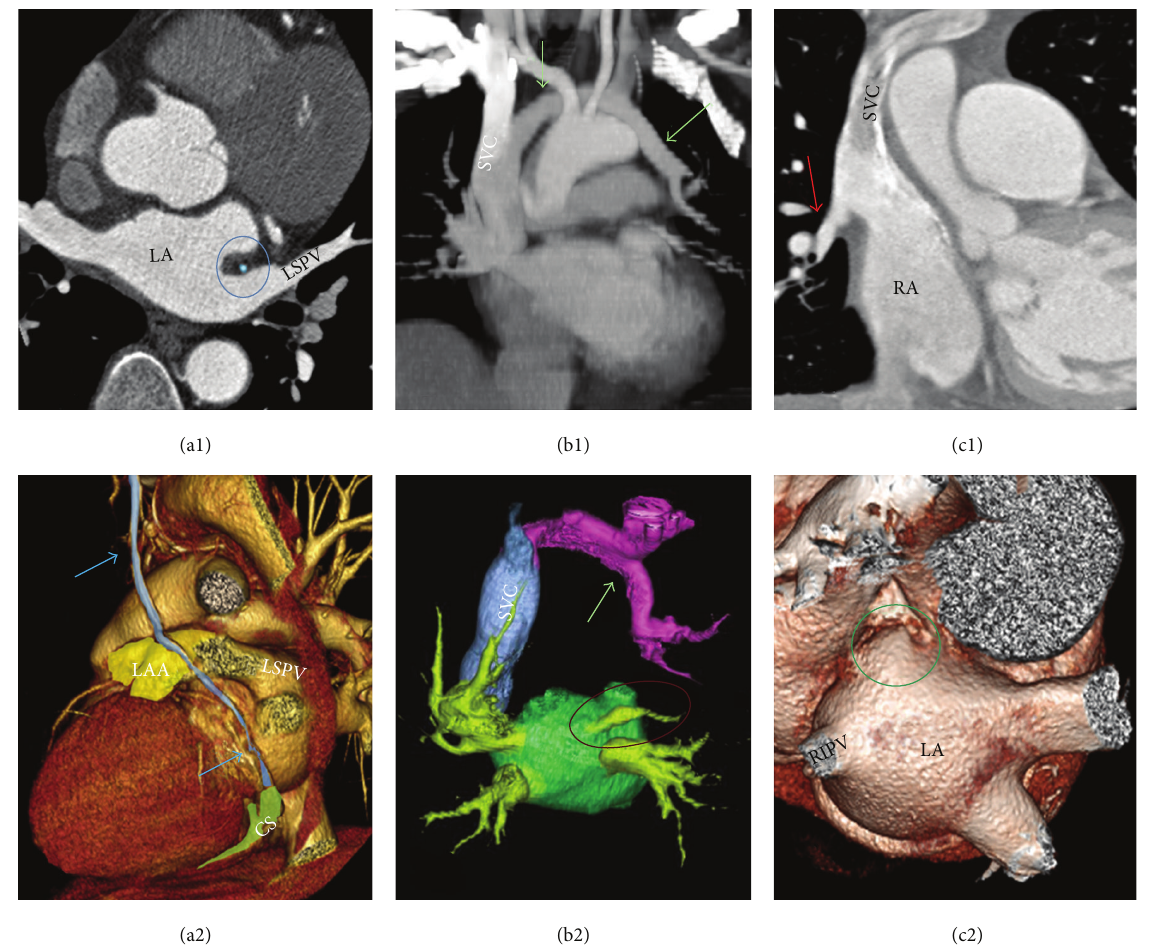
Figure 5: CT slices (top) and view of volume rendered CT angiographies (bottom) are shown. (a1) and (a2) demonstrate a patent vein of Marshall (blue arrow and within the blue ring) passing between the left atrial appendage (LAA) and the left superior pulmonary vein (LSPV) before joining the coronary sinus (CS). (b1) and (b2) are partial anomalous pulmonary venous (green arrows) return draining part of the left upper lung into the superior vena cava (SVC). Note that the left superior pulmonary vein exists (within red circle) but appears diminutive compared to the other veins. (c1) and (c2) show partial anomalous pulmonary venous (red arrow) return draining part of the right upper lung into the SVC. In this case, the right superior pulmonary vein is absent (green circle). RIPV = right inferior pulmonary vein. (b2) and (c2) are flipped for better